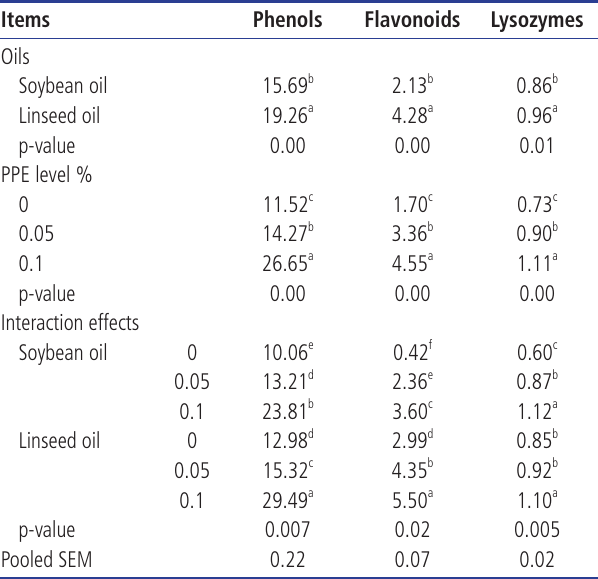
Table 9. Effects of different dietary levels of pomegranate peel extract with different oil sources and their interactions on total phenol and total flavonoid contents of breast muscle (μg/g fresh weight) and lysozyme activity (μ/mL) Items Phenols Flavonoids